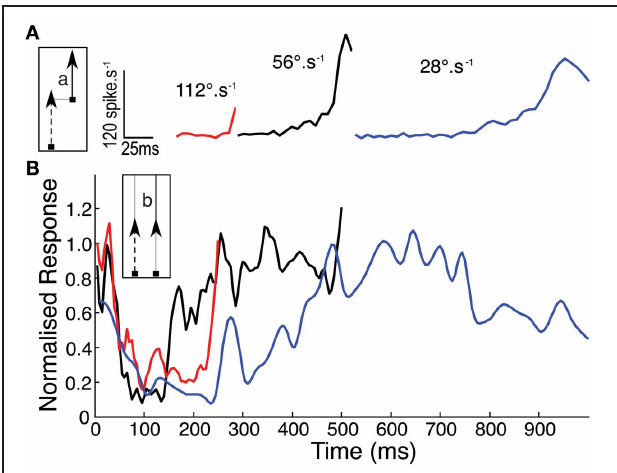
FIGURE 4 | (A) Mean CSTMD1 response during the second segment (a) of the 28 ◦ two path stimulus, illustrates the onset time course at each of the three velocities ( n = 30, 3 trials of 5 traversals in 2 neurons). (B) To account for spatial inhomogeneity of the receptive field, time courses in (A) are normalized by response during the second half (b) of the corresponding single path experiment (i.e., in the facilitated state). Normalized responses initially decrease as “left over” excitation from the first path decays. At 28 ◦ .s − 1 , response builds over hundreds of milliseconds more slowly than the 56 and 112 ◦ .s − 1 time courses.